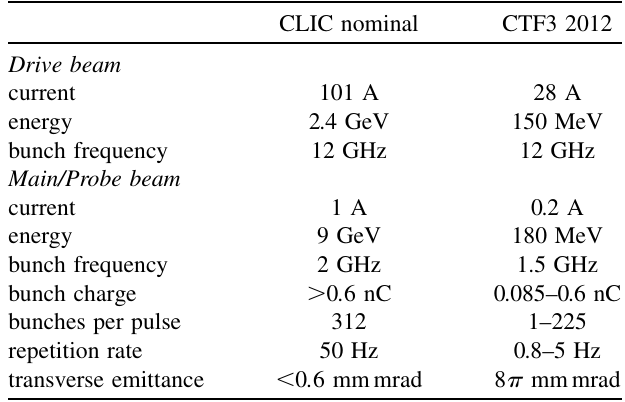
TABLE I. Summary of CLIC and CTF3 beam parameters.